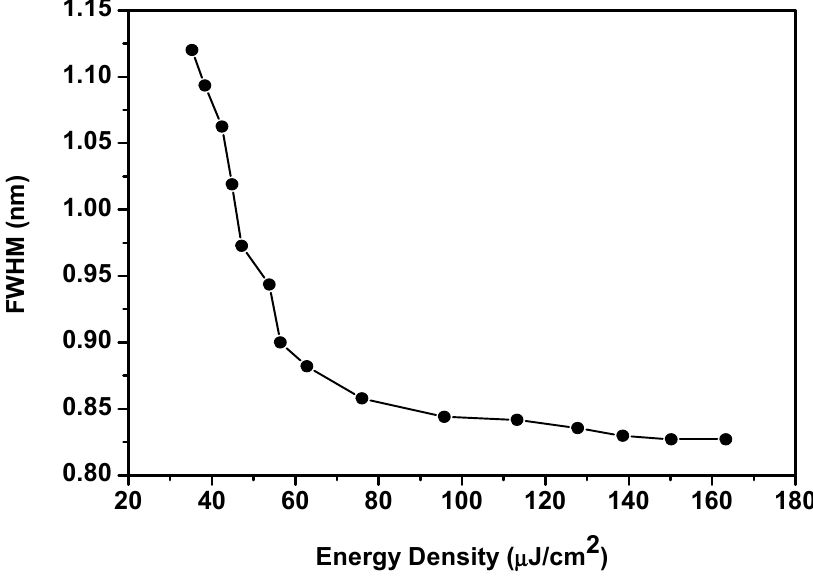
Figure 4. Full width half maximum (FWHM)–energy density relation for the P5T crystal.